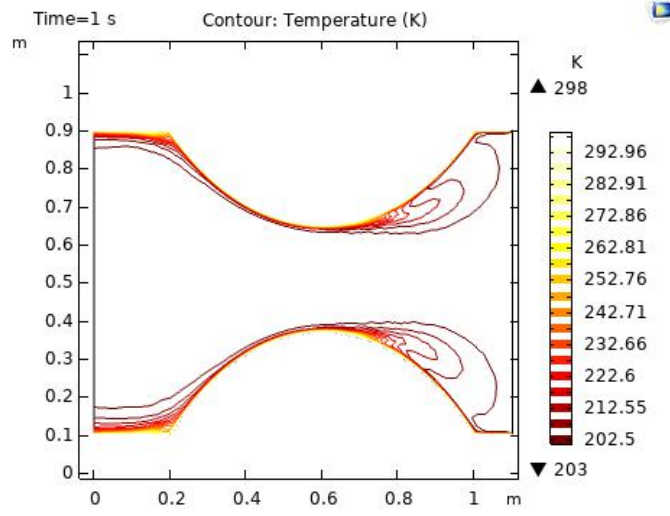
Figure 19. The isothermal contour profile at t = 1 s.